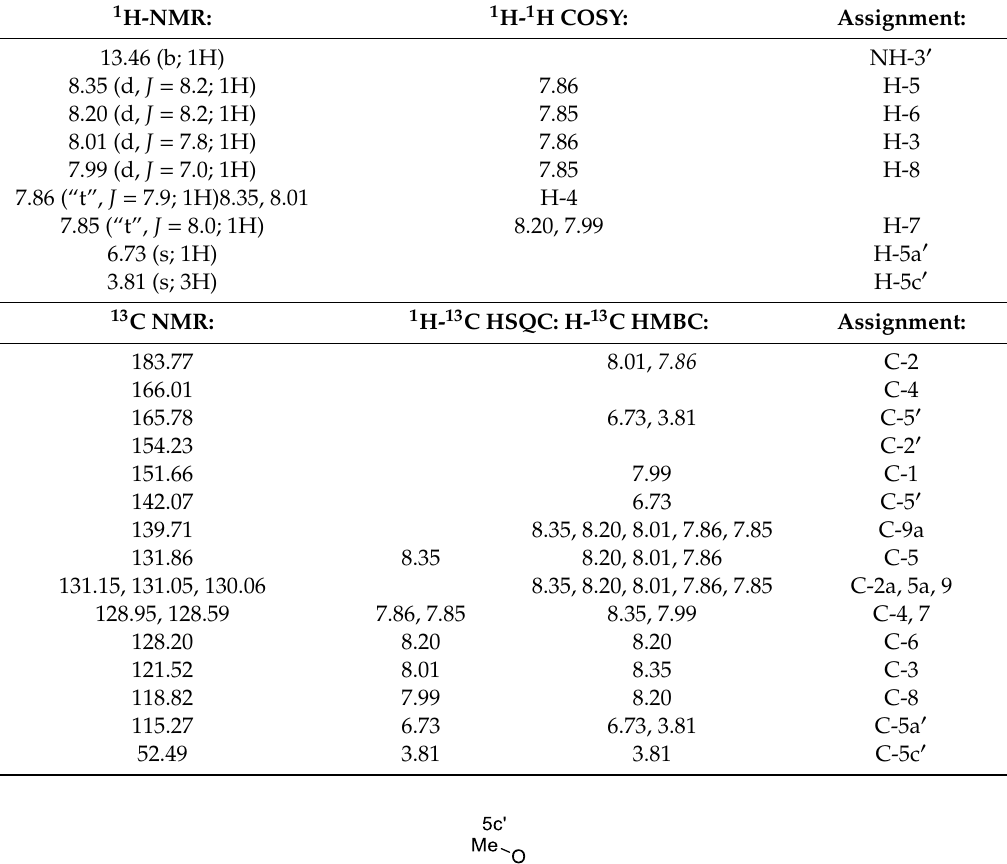
Table 1. NMR spectroscopic data of 7a .